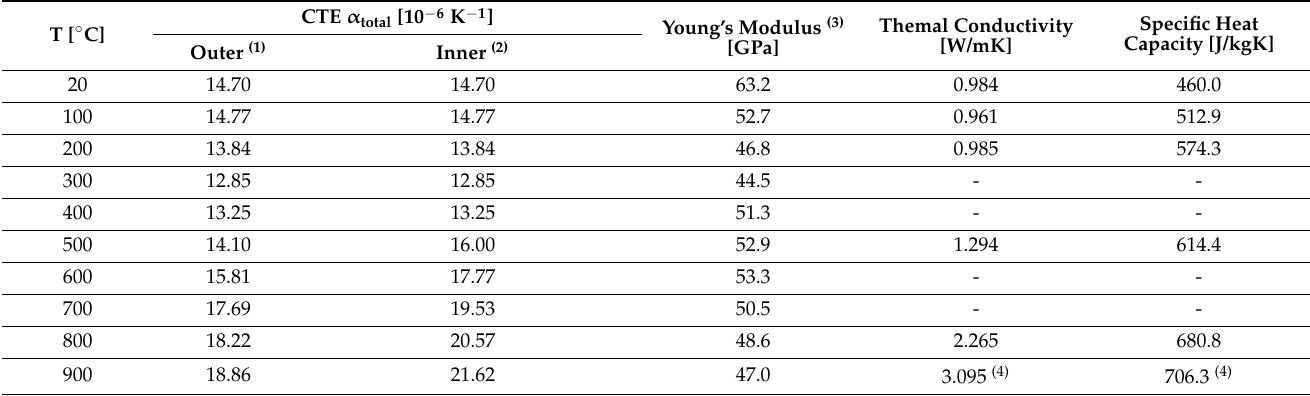
Table A2. Input parameters for the simulation of a tubular BSCF membrane during three